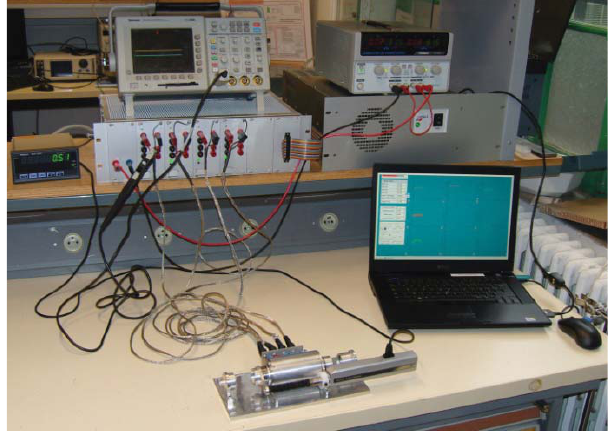
Figure 4. Test bench of Pulsamag prototype.